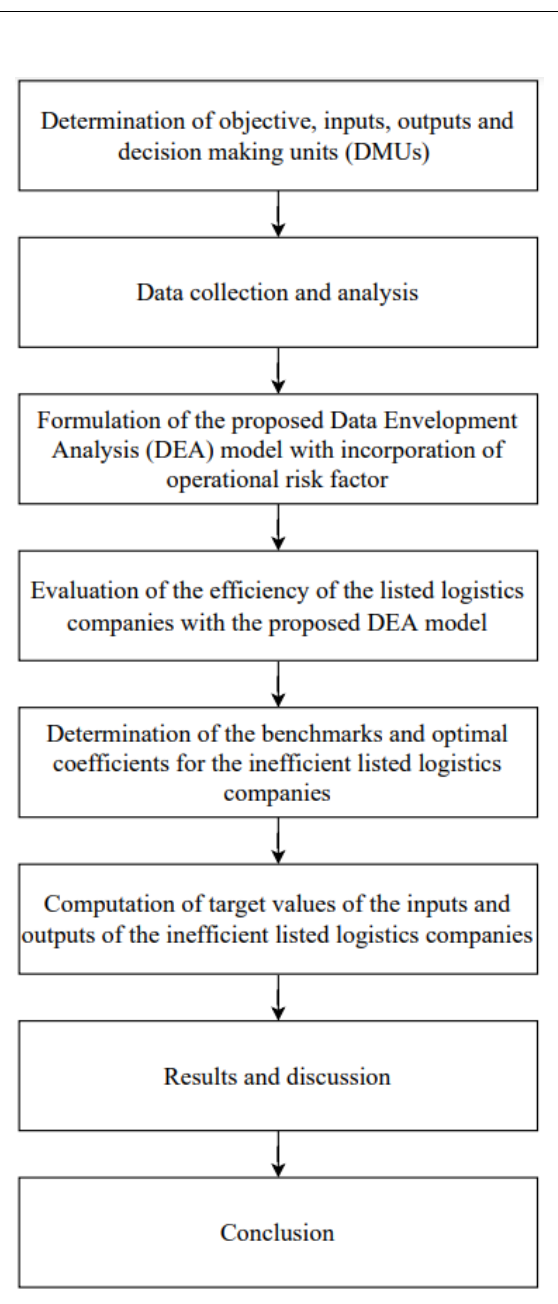
Figure 1. Research flowchart.